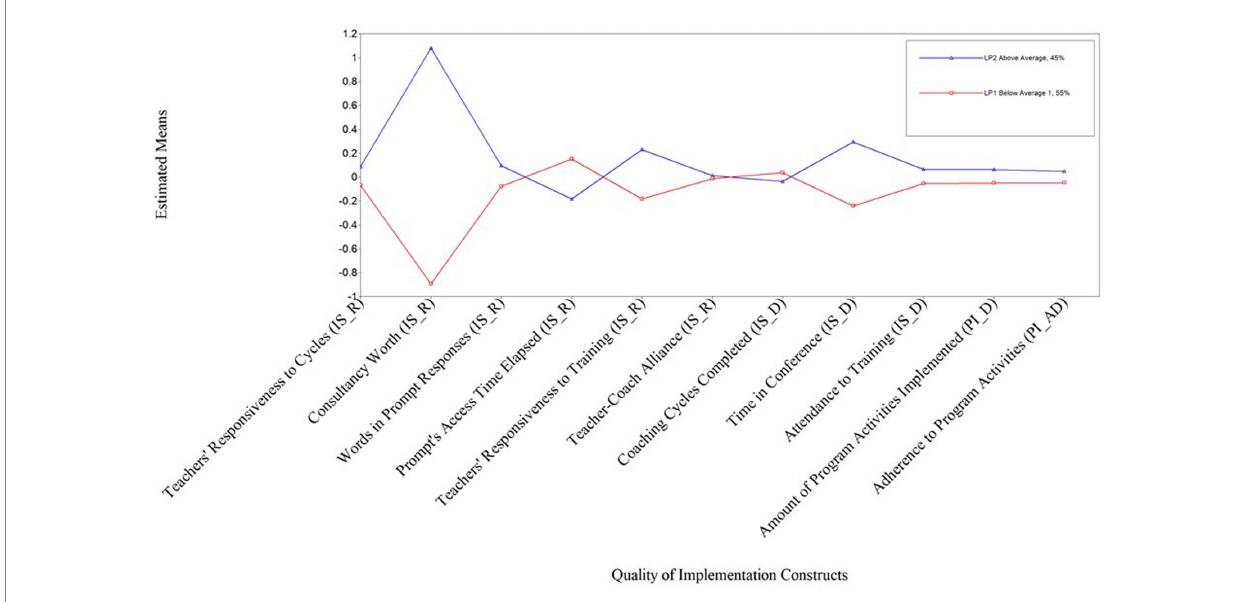
FIGURE 3 Estimated means of quality of implementation constructs by latent profile IS_R, Implementation Support Responsiveness; IS_D, Implementation Support Dosage; PI_D, Program Implementation Dosage; PI_AD, Program Implementation Adherence.